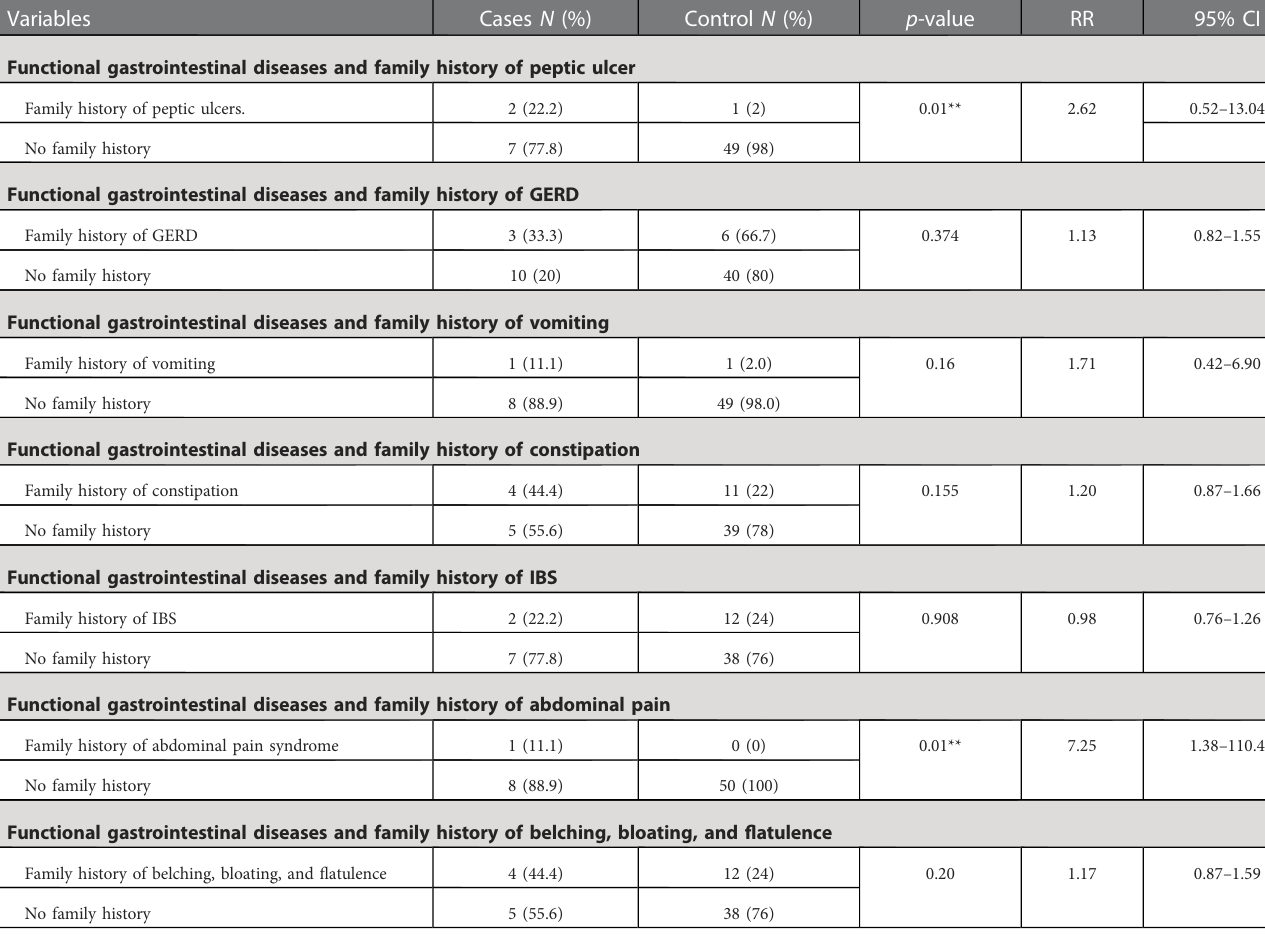
TABLE 4 Relationship between gastrointestinal family history and functional gastrointestinal diseases. Variables Cases N (%) Control N (%) p- value RR 95%